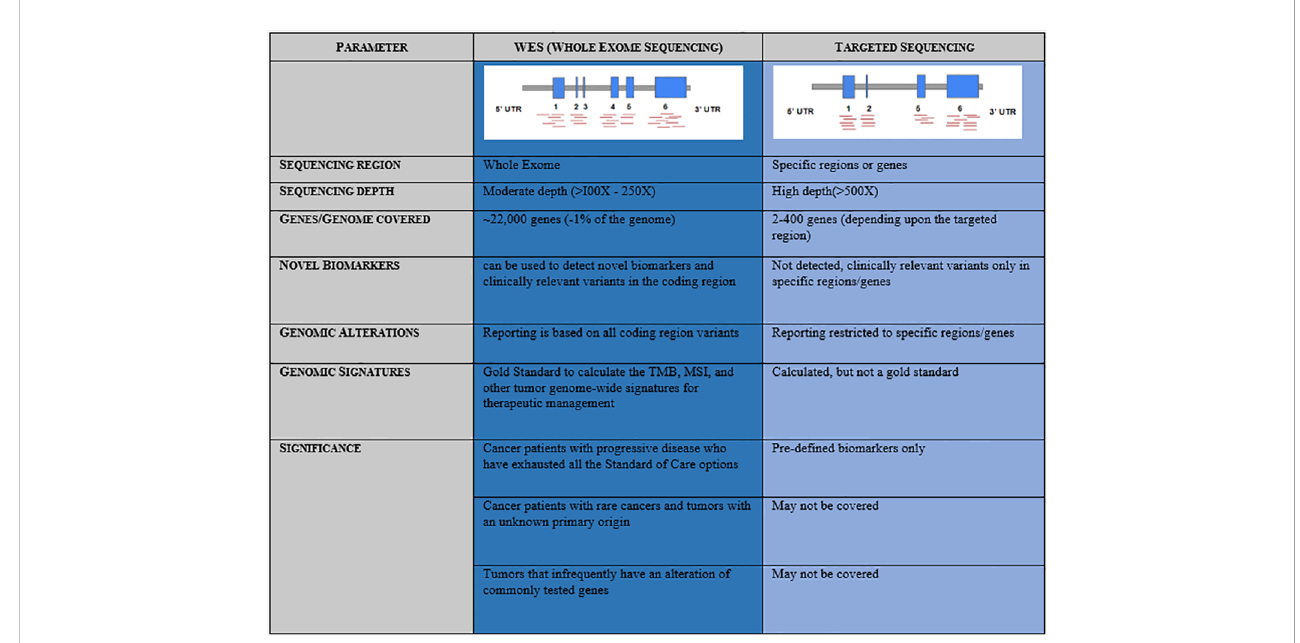
FIGURE 1 Comparative representation and advantage of Whole Exome Sequencing (WES) over Targeted Sequencing